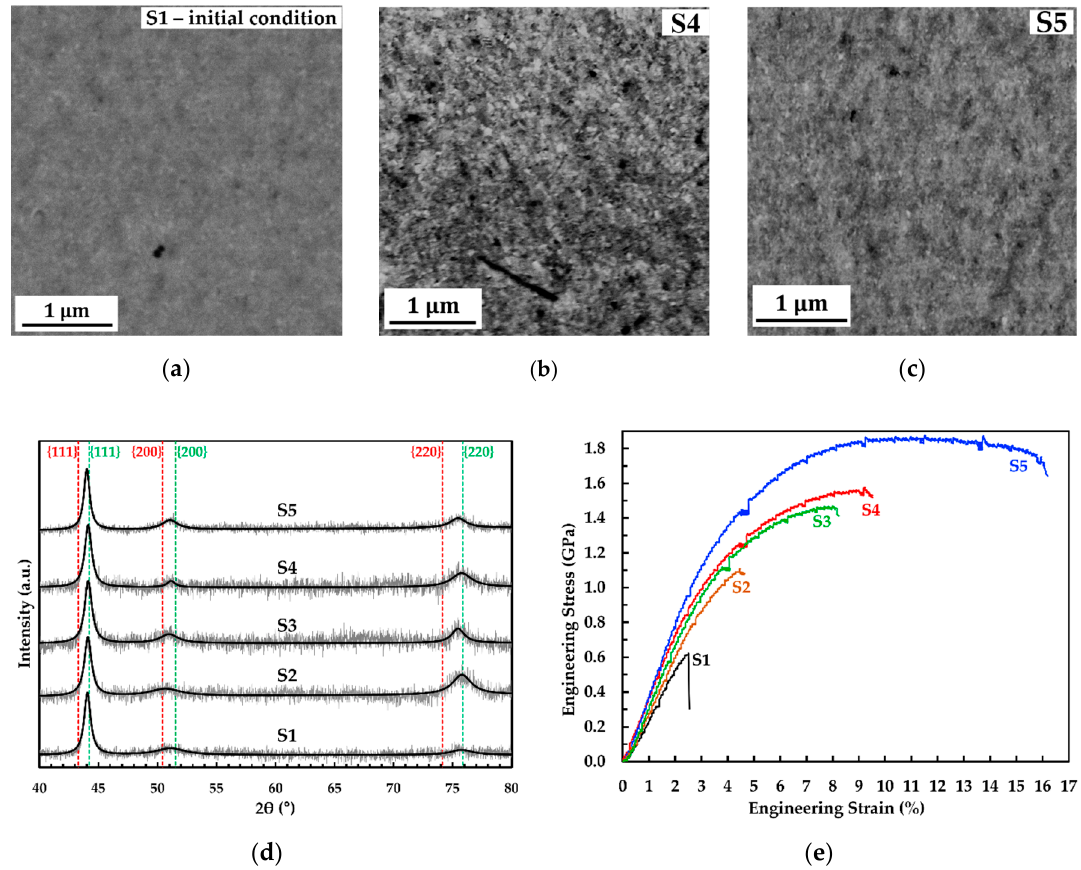
Figure 2. Back-scattered electron (BSE) image of initial microstructure of ( a ) S1, ( b ) S4, ( c ) S5 in planar mode; ( d ) X-ray diffraction (XRD) patterns of S1–S5. The red and green vertical dashed lines indicate the positions of the face-centered cubic (fcc) phase lines of Cu and Co, respectively. The continuous black thick lines correspond to the fits for the measured XRD patterns; ( e ) Engineering stress vs. strain curves of static tensile tests of samples S1–S5 at a strain rate of 1.0 × 10 − 3 s − 1 . Detailed descriptions for each sample are shown in Table 2. Table 1. Chemical composition and grain size analysis of the tensile specimens, which were deposited at (various) pulse current density (i p ), duty cycle (dc), and pulse-on time (t p ). Grain size analysis is measured from the XRD lines in Figure 2a through full width at half maximum (FWHM) analysis and two different approaches: Scherer plot and Williamson–Hall plot. PED = pulsed electrodeposited. PED Parameters Composition Scherer Plot Williamson–Hall Plot